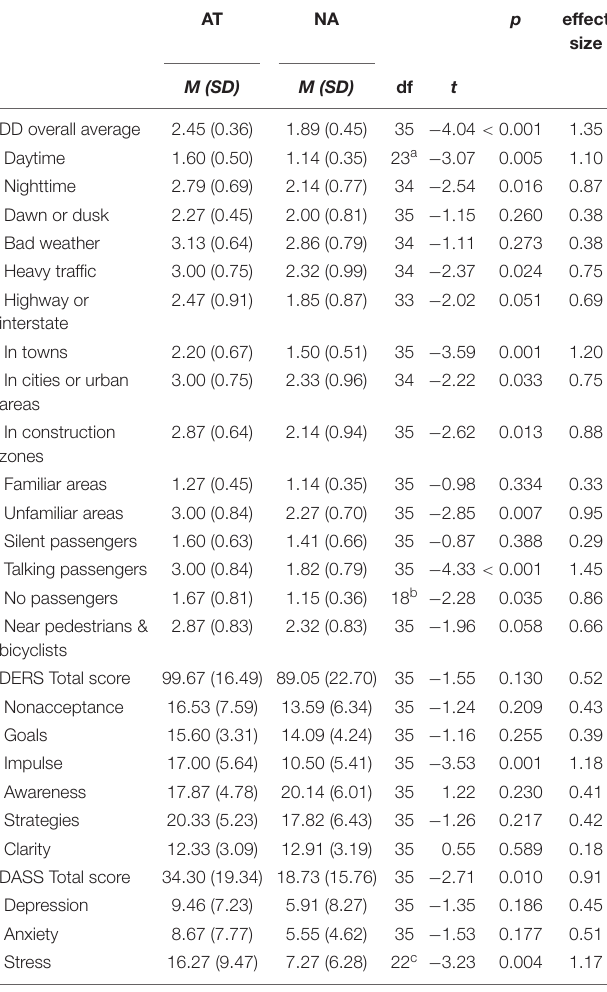
TABLE 2 | Group differences on driving in participants 16 + years old. TABLE 3 | Group differences on DD, the DERS, and the DASS.